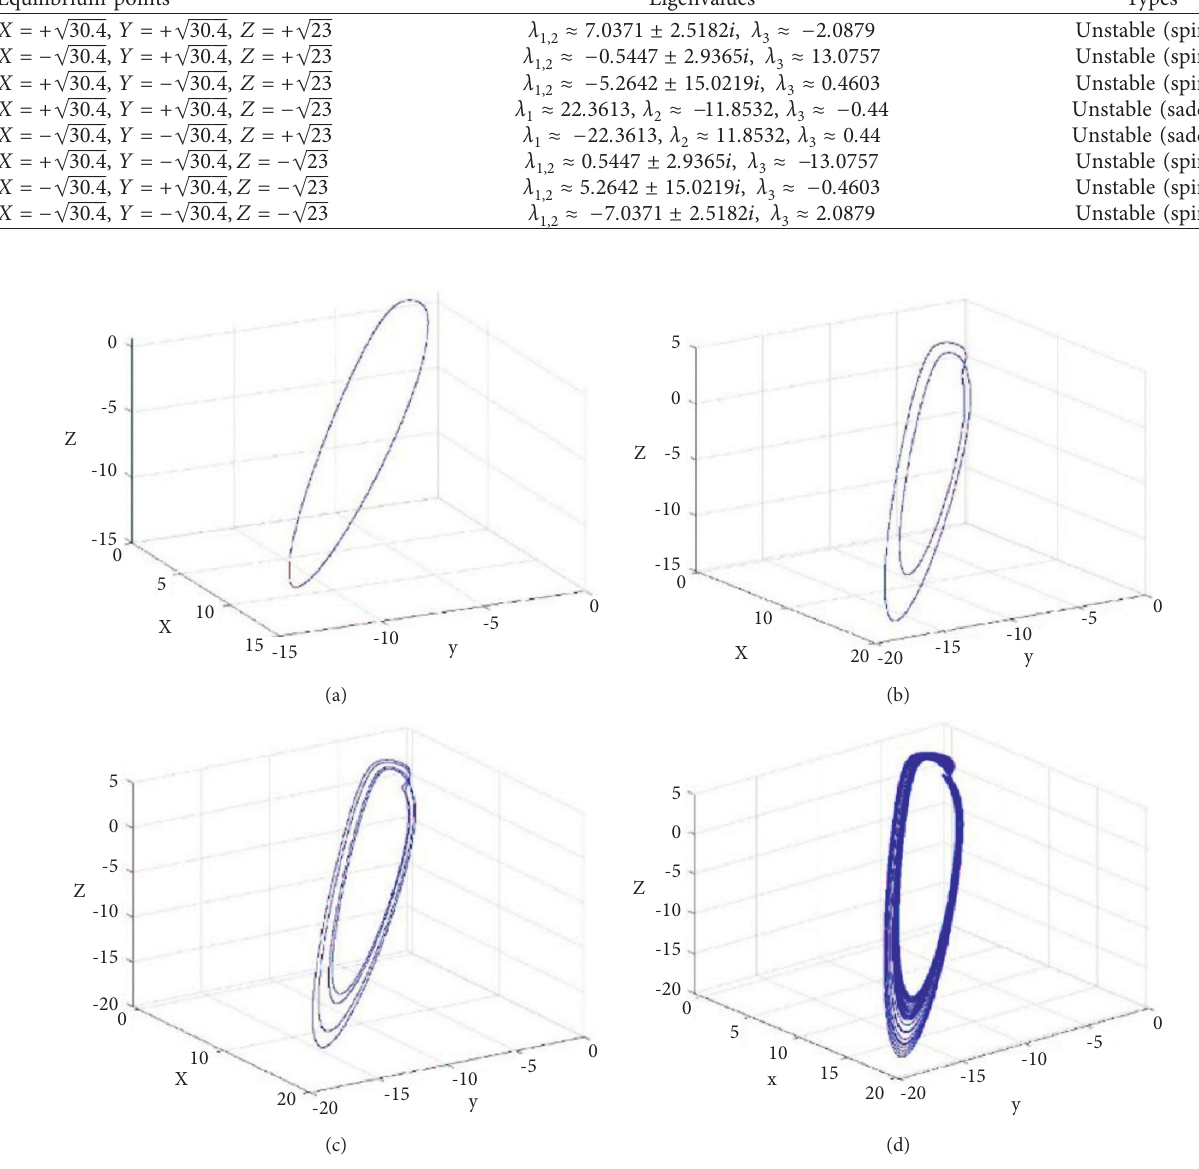
Figure 1: The systems’ attractors for a ’s different values when b � − 2 . 3. (a) For a � 3 , period 1 can be seen in the system’s attractor. (b) For a � 2, period 2 can be seen in the system’s attractor. (c) For a � 1 . 5, period 3 can be seen in the system’s attractor. (d) When a � 1 . 1, the oscillator’s behavior is